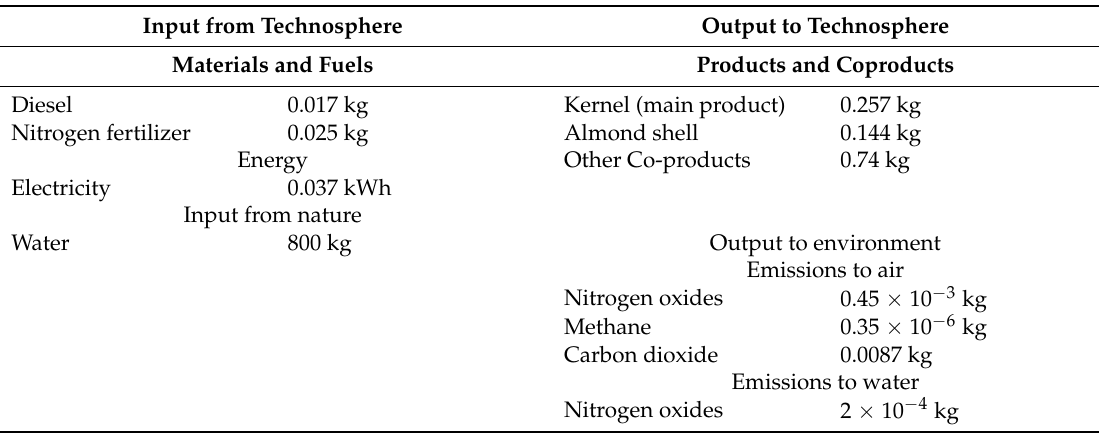
Table 1. Global inventory data (per 1 MJ H2 ) for Subsystem 1.